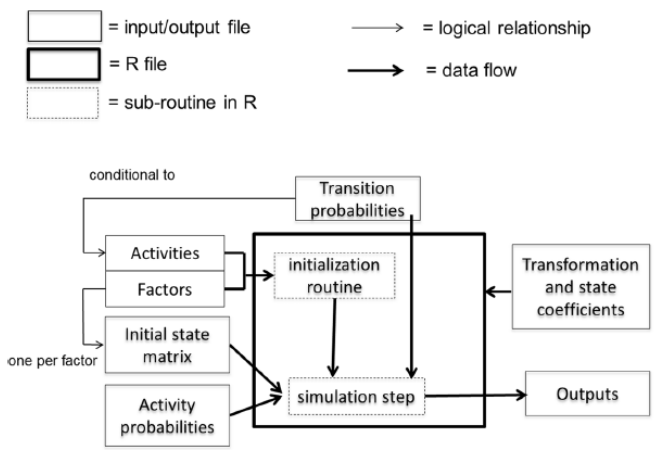
Figure 2. The parameter environment of the EFDM simulation runs [7].